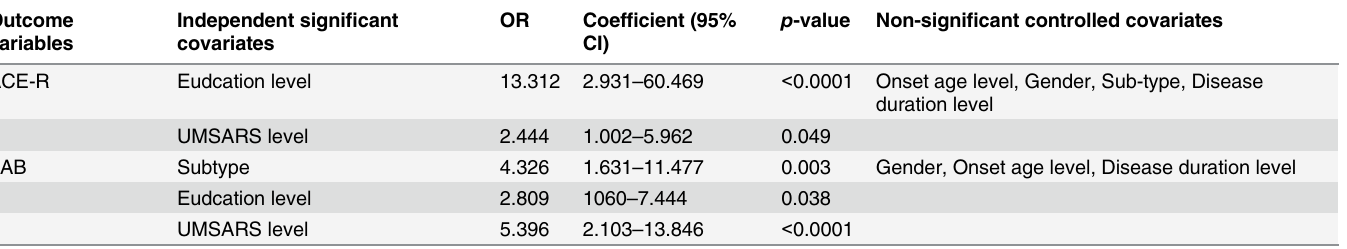
Table 5. Regression analyses predicting the outcome, with adjustments for non-significant but clinically important covariates. Each row repre- sents a separate regression